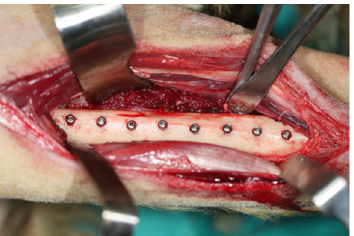
Figure 2. Surgical view of the sheep tibia with placed implants .